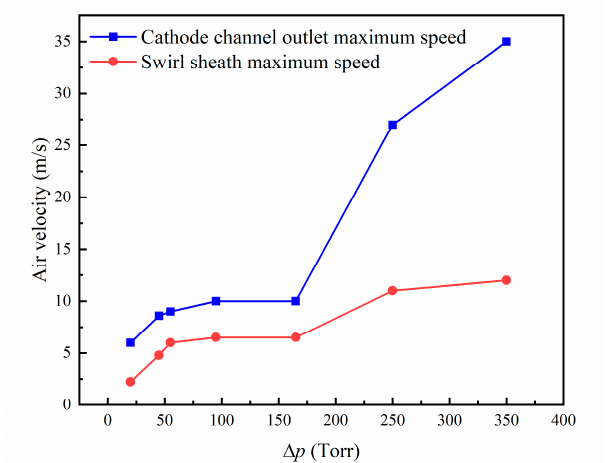
Figure 10. The maximum airflow velocity and the maximum swirl sheath velocity at the outlet of the cathode channel.